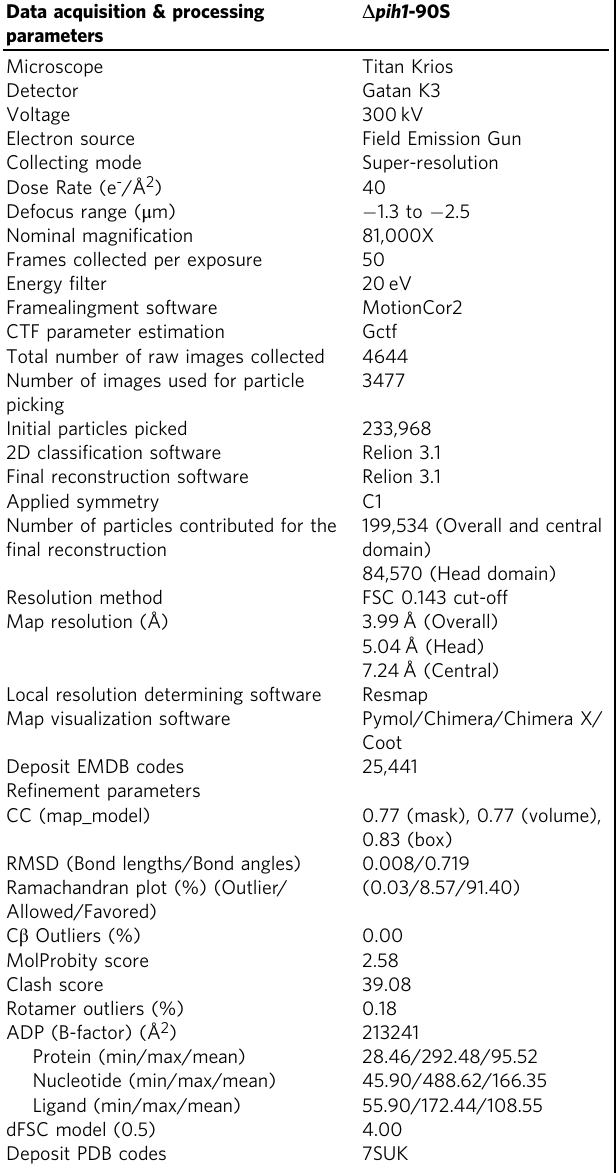
Table 1 Data Acquisition, Processing and Model Re fi nement. Data acquisition & processing